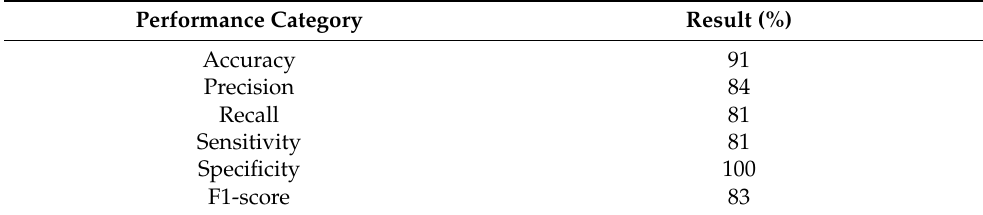
Table 6. COVID-19 Cough Model Performance Table.